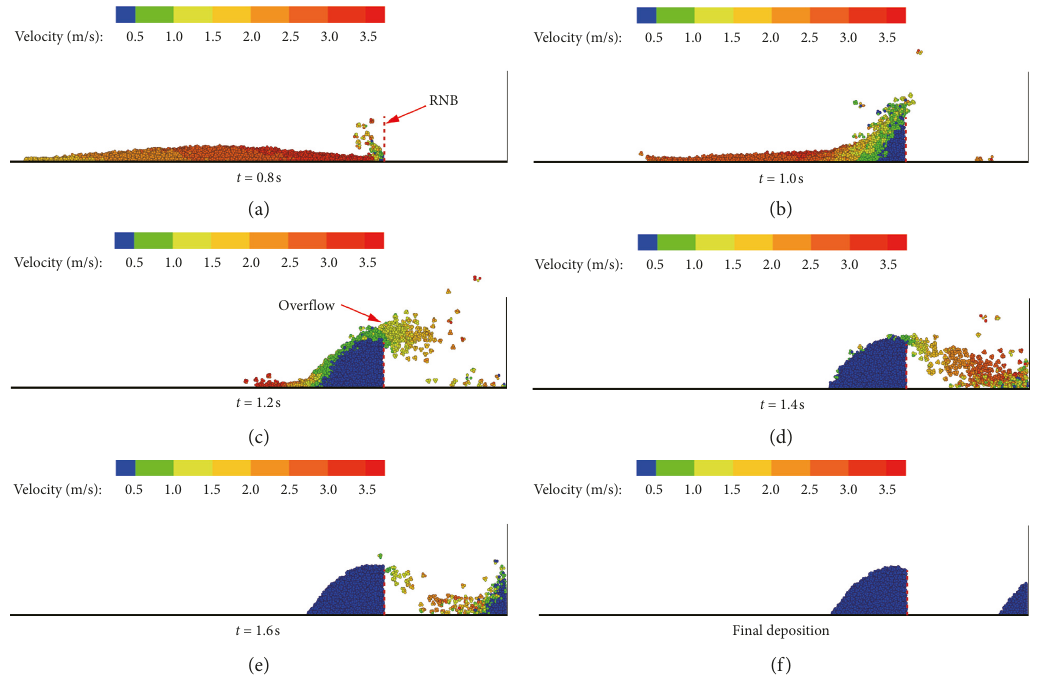
Figure 13: Granular flow process in Case B2.